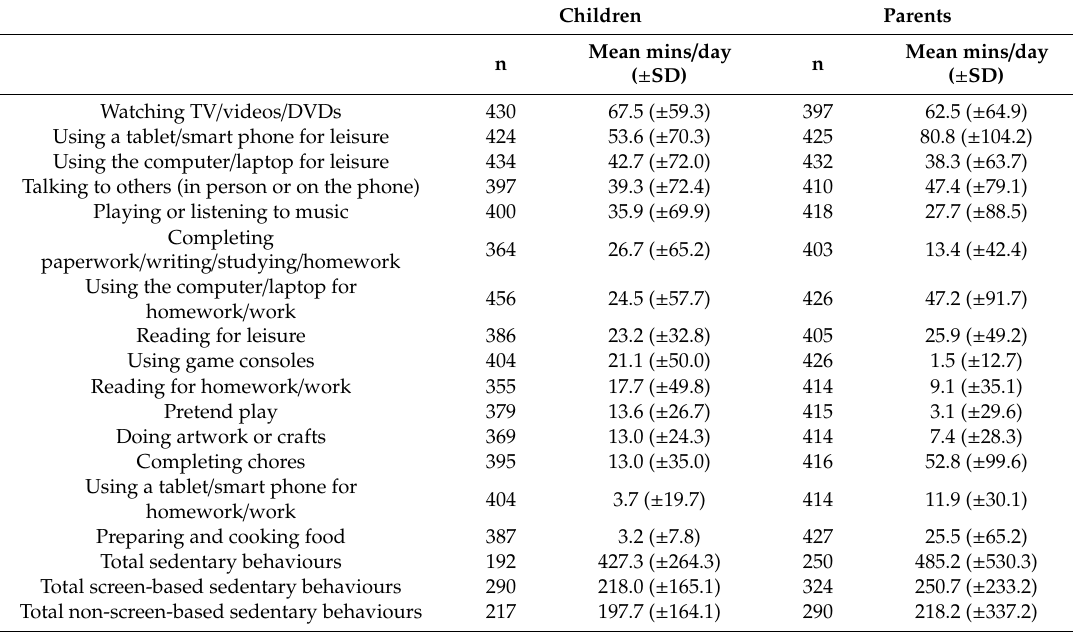
Table 1. Mean daily duration (minutes / day ± standard deviation (SD)) of home-based sitting behaviours by children and parents.